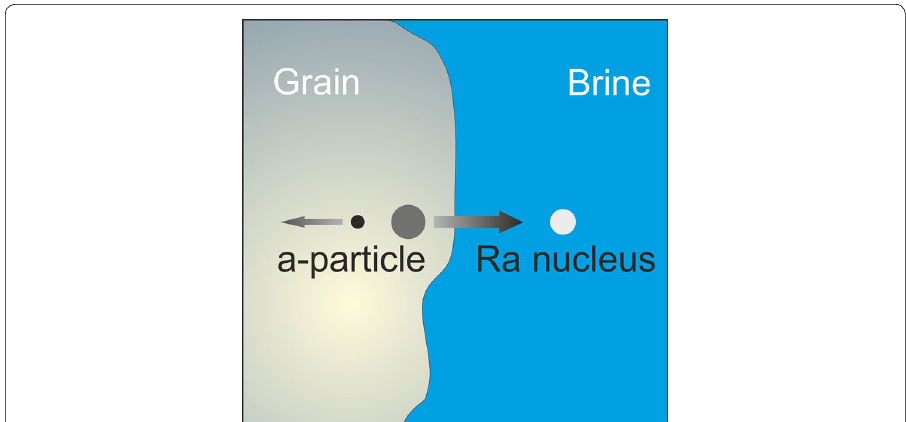
Fig. 6 Schematic diagram of alpha-recoil mechanism. Mobilization of a radioactive daughter from its initial position by the energy of an alpha decay. Arrow size reflects energy